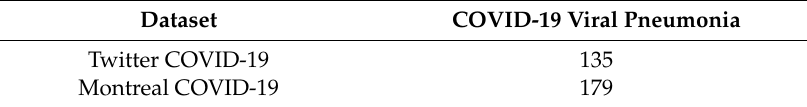
Table 3. Distribution of COVID-19 CXR